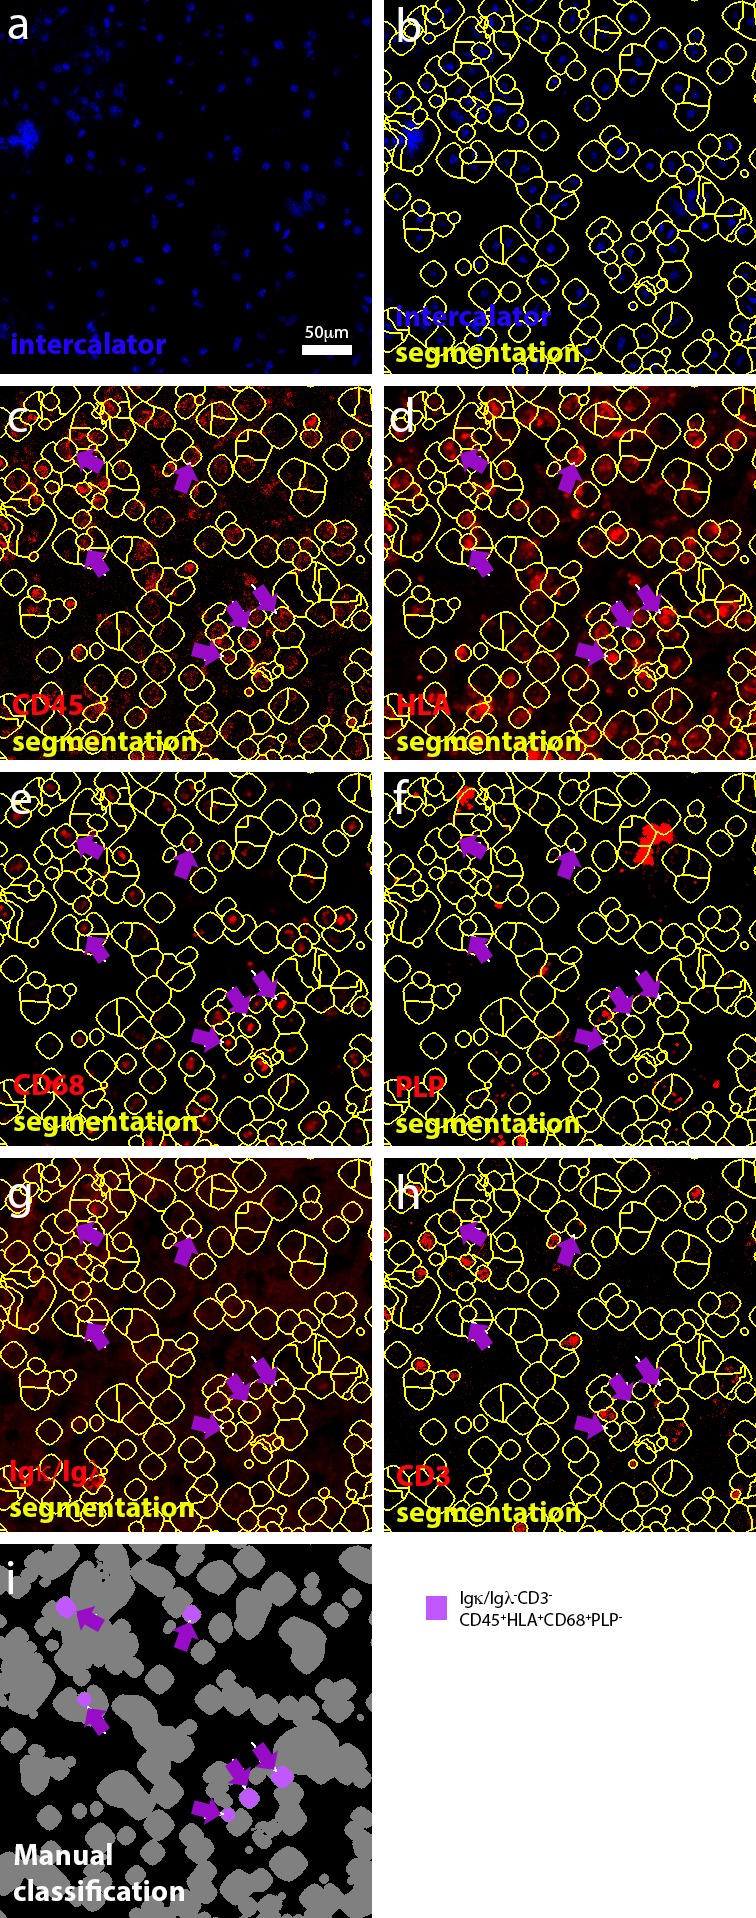
Manual selection of myeloid cells.(a) Representation of manually-annotated cells in an active lesion, based on the detection of nuclei. (b) Segmented cells. (c–h) Identification of cells that express (for example CD45+HLA+) or do not express (for example Igκ/Igλ-CD3-) a biologically relevant set of markers. (i) Classification of myeloid cells. Purple arrows were used throughout (c–i) to track myeloid cells.